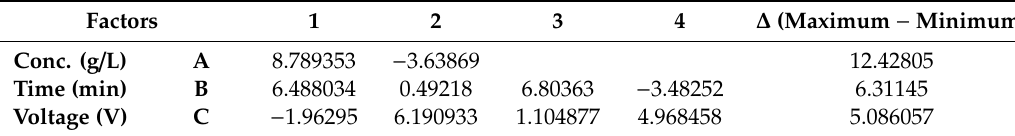
Table 5. S / N response for the deposition yield of zein / HA coatings.